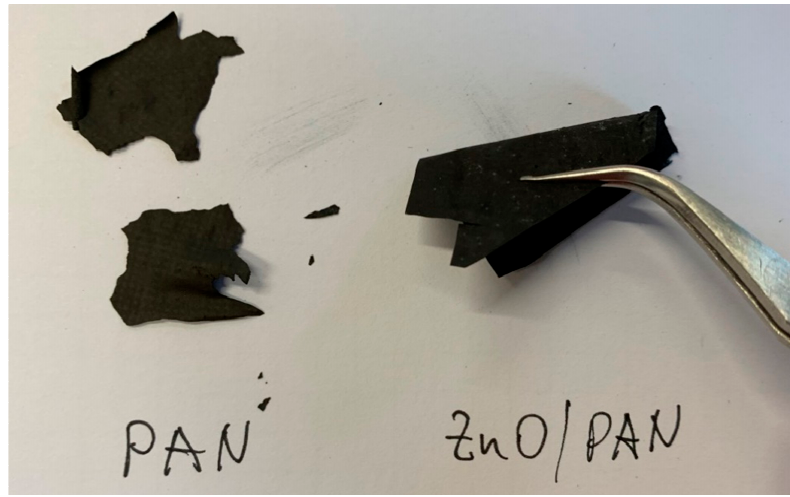
Figure 5. Bending a carbonized PAN nanofiber mat (stabilized without fixation) only slightly results in brittle failure ( left side), while bending carbonized PAN/ZnO nanofiber mats (stabilized without fixation) is possible with a narrow bending radius ( right side).